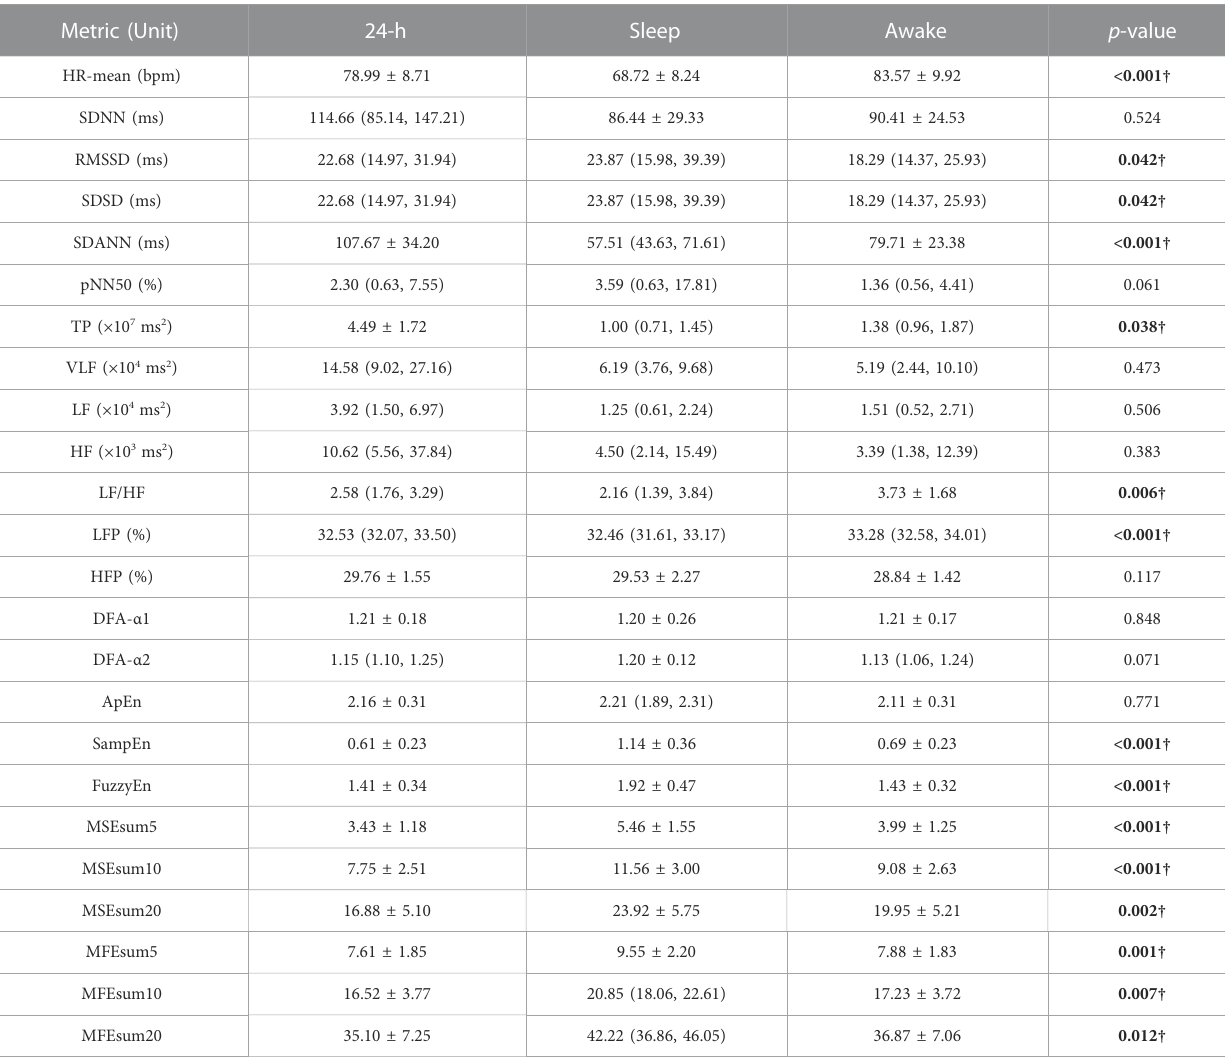
TABLE 4 HRV metrics for subjects during different recording period. Metric (Unit)